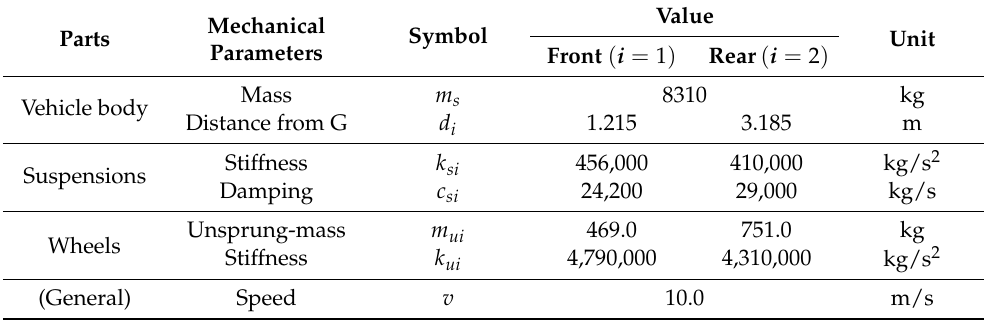
Table 1. The vehicle parameters. Parts